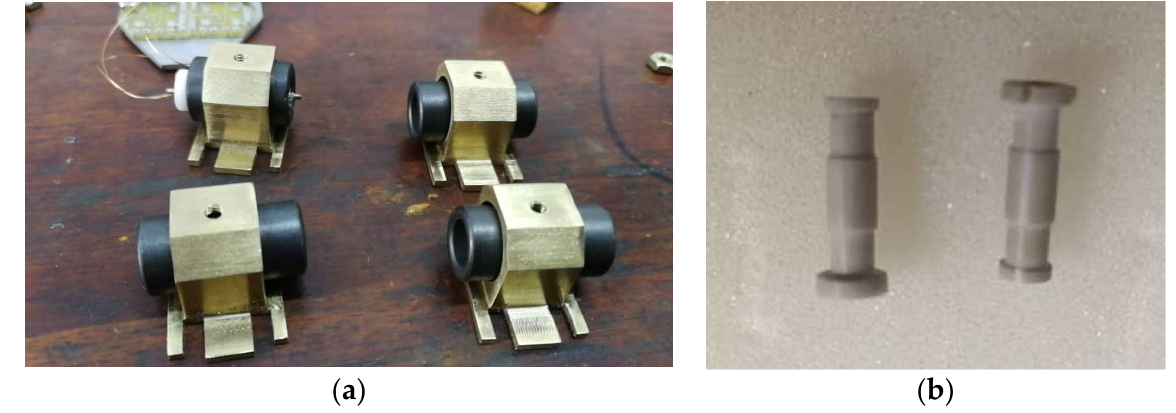
Figure 8. Sensor coil and skeleton: ( a ) Magnetic shield ring; ( b ) Coil skeleton. To compare the time drift of the DIFOD sensors using different signal conditioning circuits, the four sensors are first calibrated with the BCT-5C. The measurement range of the sensor is 0–300 µ m. Then, the four sensors are installed on the BCT-1C, BCT-5C, and micro- displacement actuator and these are placed together in the environmental experimental box. The displacement values of the four sensors are 150 µ m by adjusting the fixtures. The temperature of the environmental experiment box is controlled at 20 ◦ C. The sensor data are recorded at every minute. The entire experiment requires 24 h to stabilize. Figure 9 presents the experimental data for the stability assessment of the four sensors. Figure 9a illustrates some directional drift within 24 h after installation; Figure 9b illustrates the time drift of the four sensors after stabilization of 24 h.